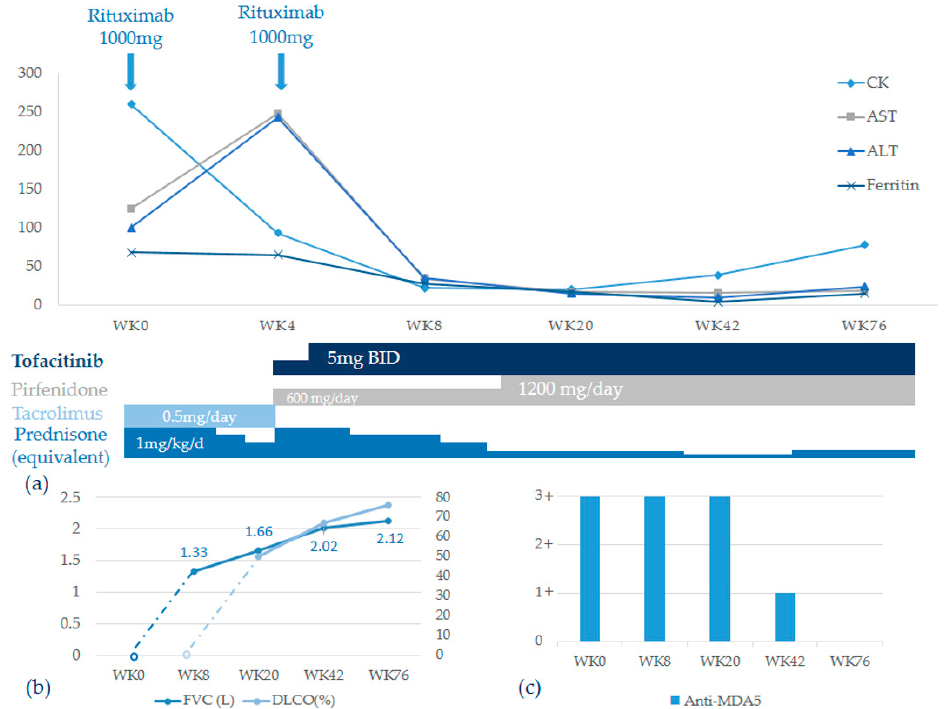
Figure 2. Clinical course of treatment, lung function, and anti-MDA serum level at follow-up. ( a ).